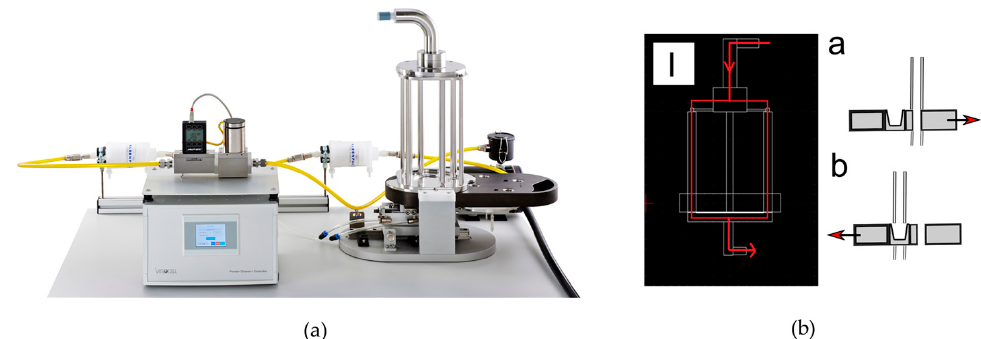
Figure 1. Vitrocell ® Powder Chamber (VPC) as an aerosol exposure system for pollen deposition. ( a ) composition of the VPC consisting of a tube for particle dosing, sedimentation tubes, exposure tray, and a controller [18]; ( b ) the air/pollen flow is indicated by the red line through the sedimentation